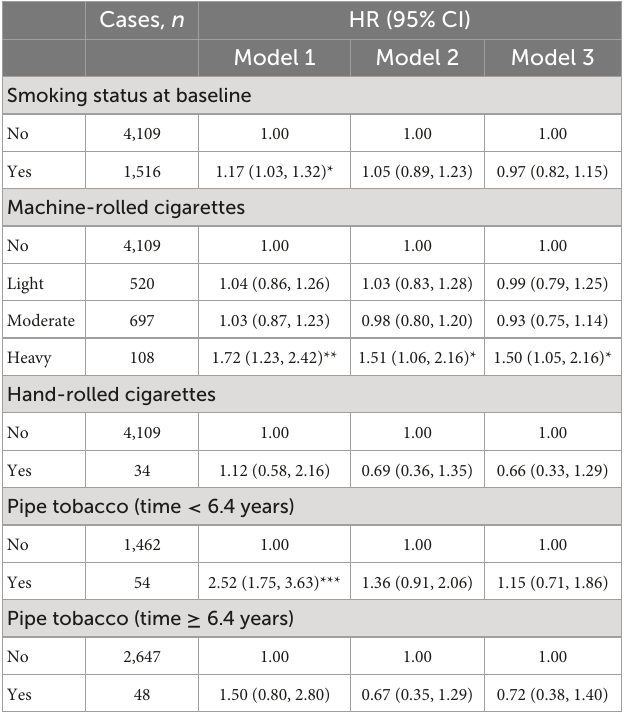
Model1:novariableswereadjusted. Model2:adjustedforage(continuousvariable)andsex. Model 3: model 2 plus area, ethnicity, marriage, occupation, alcohol use, physical activity, history of diabetes, SBP, total cholesterol, triglycerides, HDL-C value, LDL-C value, and baselineBMIvalue. *** P < 0.001,** P < 0.01,* P < 0.05.